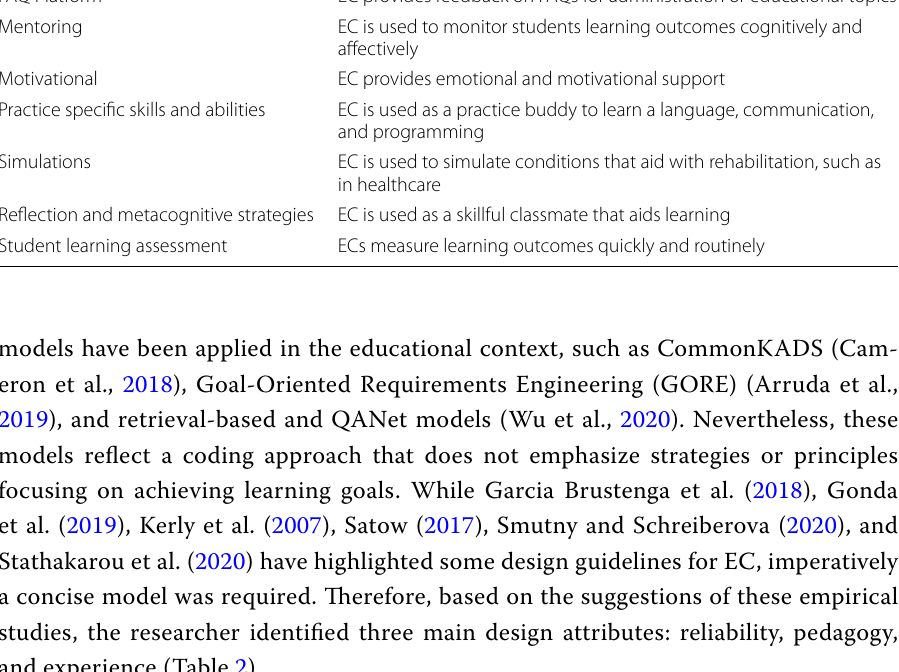
Table 1 Educational task of ECs Task Description Administrative and